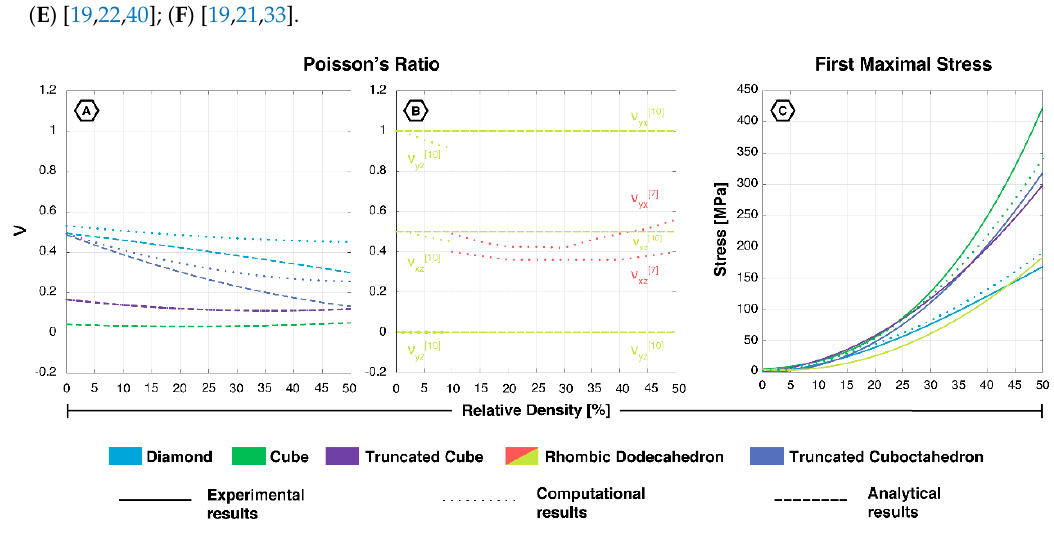
Figure 7. ( A ) Poisson’s ratio of the diamond, cube, truncated cube and truncated cuboctahedron and ( B ) rhombic dodecahedron; ( C ) first maximal stress of all five unit cells, based on experimental [12,18,33–37,39,44,45,47–51,55] , computational [19,22,33,40,42] , and analytical data [19,21,22,33] .